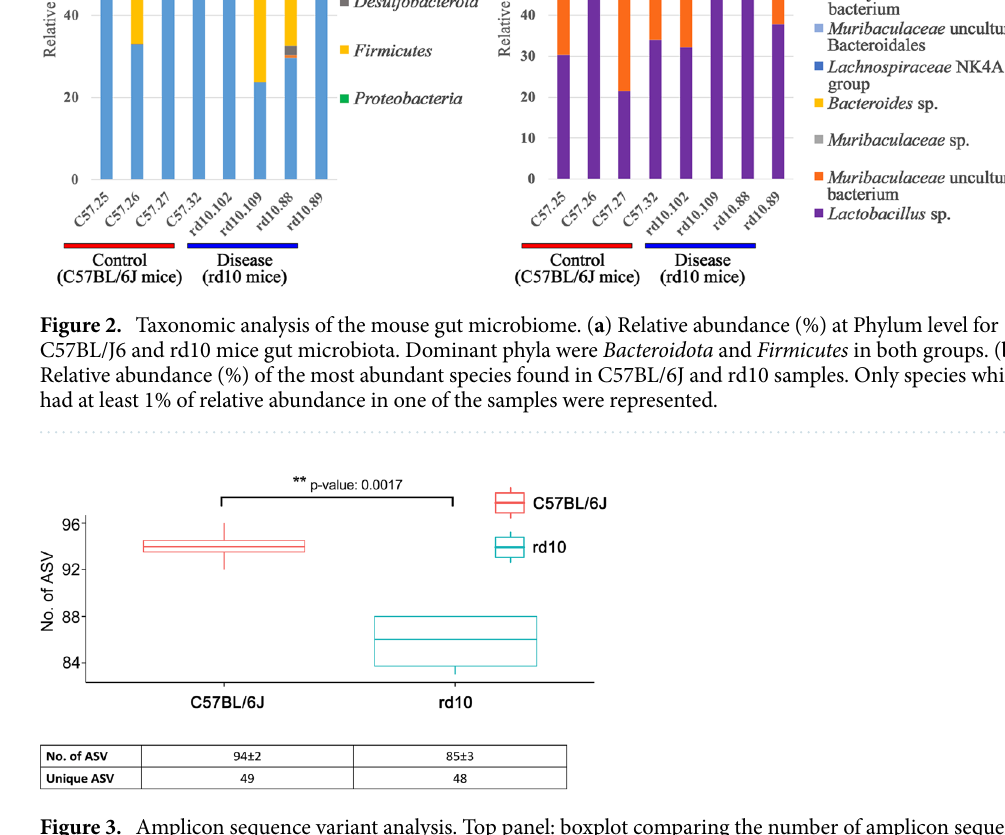
Figure 3. Amplicon sequence variant analysis. Top panel: boxplot comparing the number of amplicon sequence variants (No. of ASV). One-way ANOVA test showed statistically significant differences between the number of ASV in healthy (red) and rd10 (blue) mice. First row of the table contains mean ± SD of ASV, the second one contains the number of unique ASV (not shared with the other group) for healthy (left) and rd10 mice (right). Graphic performed with the library ggboxplot available in